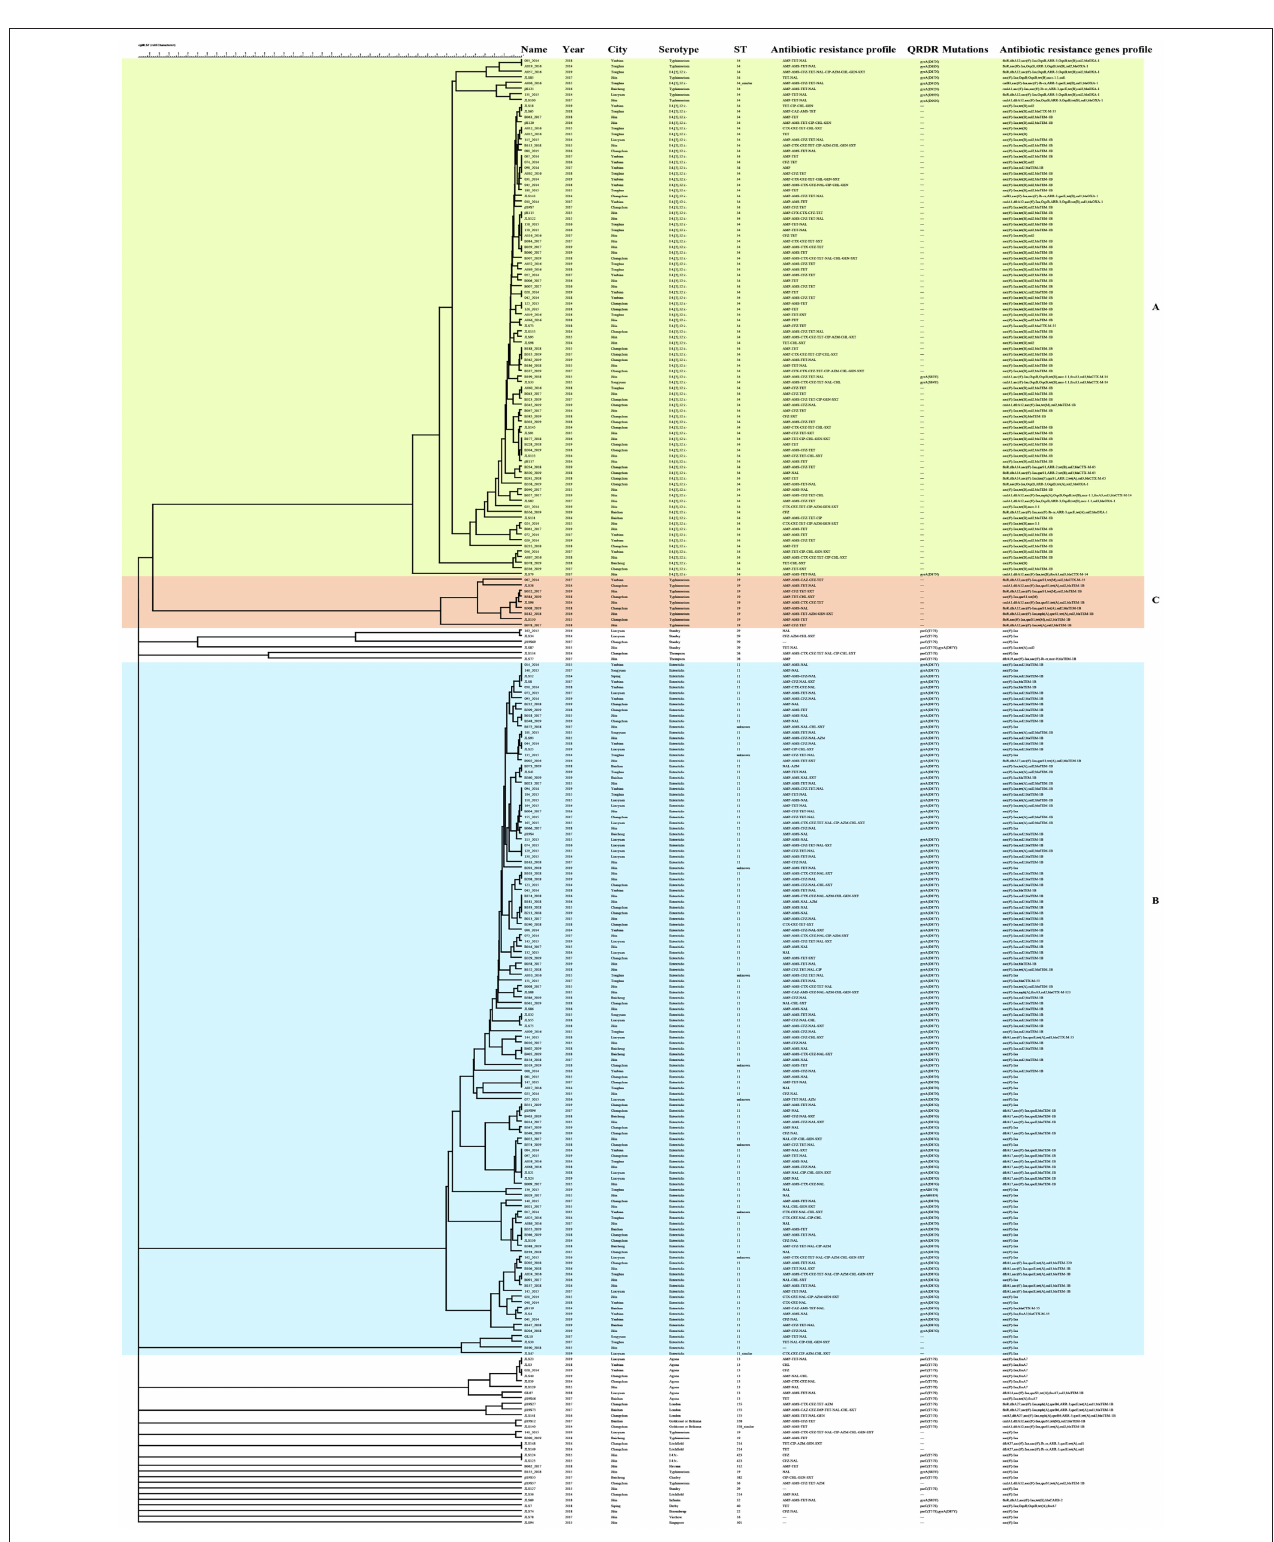
FIGURE 3 | Phylogenetic analysis of 260 Salmonella strains from diarrheic children. The entries were arranged above the picture. Isolates, such as 003_2014 and A019_2016 with no allelic differences could be identified as the same clone. Discrepancies of alleles exceeding the scale above were considered unrelated. The dendrogram mainly contains A, B, and C three parts, corresponding to 92 S .I 4,[5],12:i:- and Salmonella Typhimurium strains, 123 Salmonella Enteritidis strains, and 9 S. Typhimurium isolates. The similarity index was labeled over the clusters to show the genetic relationships.